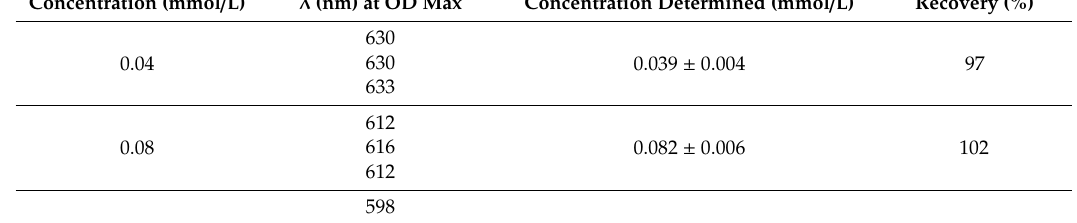
Table 2. Determination of glucose by the fabricated glucose plasmonic biosensor. Concentration (mmol / L)